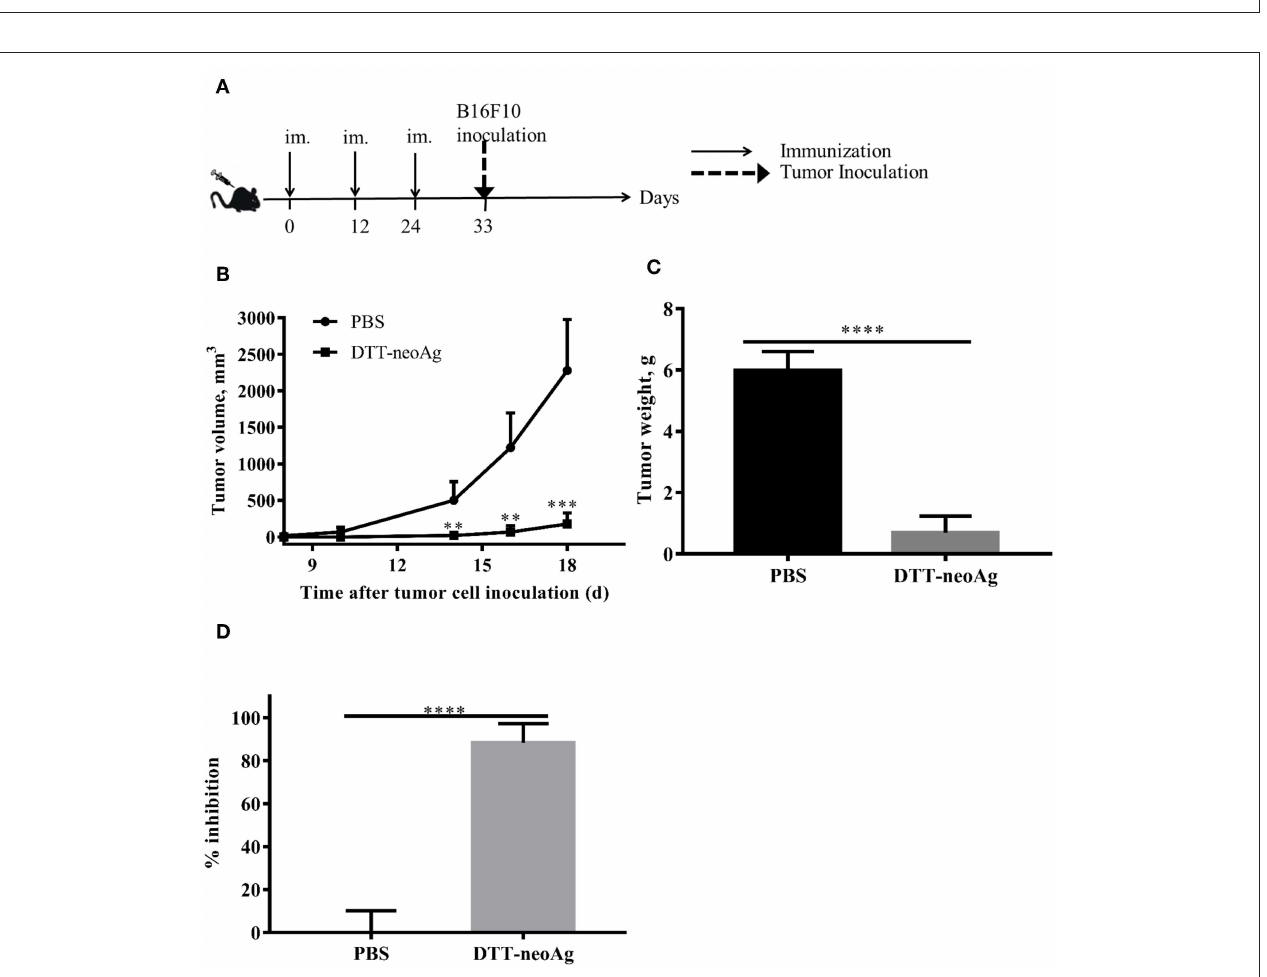
FIGURE 3 | Anti-tumor effects of DTT-neoAg vaccination in the prophylactic mouse melanoma model. The data are means ± SEM, **** P < 0.0001; *** P < 0.001; ** P < 0.01; * P < 0.05, Student’s T-test. (A) The treatment schedule. C57BL/6 mice ( n = 5) were immunized with DTT-neoAg or PBS formulated with Alum + CpG on day 0, day 12 and 24. Nine days after the third immunization, 1 × 10 5 B16 F10 cells were s.c. administered into the right flank of the mice. (B) The tumor growth curves. (C) On day 22 after the tumor challenge, tumors weights were measured. (D) Tumor inhibition rate of PBS-treated or DTT-neoAg-treated mice.